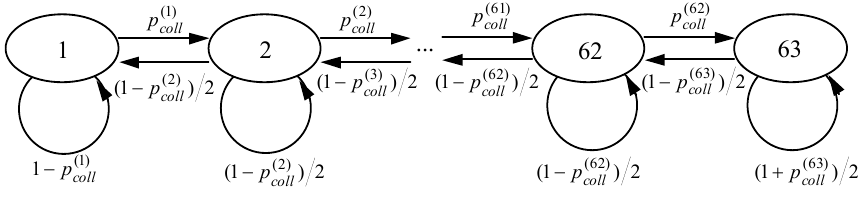
Figure 5. The state transition diagram of the Markov chain for ACK/unicast